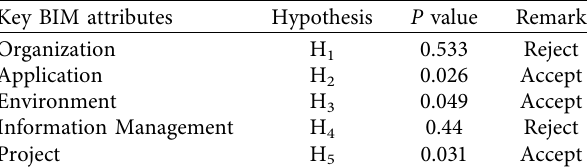
Table 8: Summary of hypothesis testing results. Key BIM